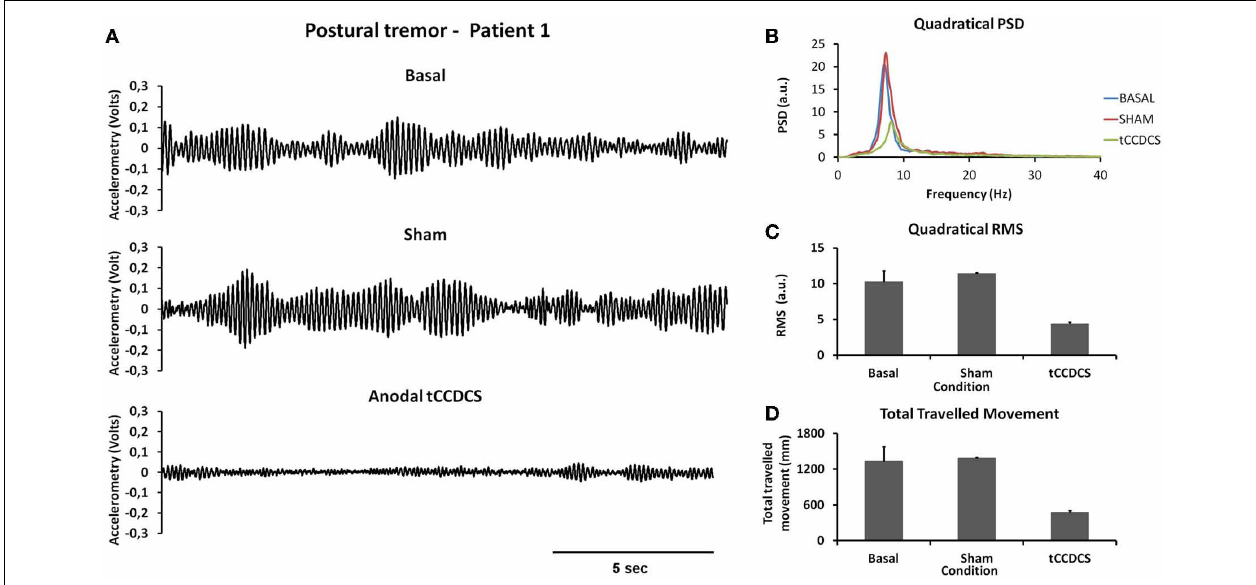
FIGURE 2 | Postural tremor in patient 1. (A) Tremor recorded at the level of right index in the 3 experimental conditions (from top to bottom: baseline, post-sham and post-tCCDCS) for the gravity axis (dominant axis in this task). Calibration value: 1.55mV = 100mm/s 2 . (B) Mean quadratical power spectral density (PSD) of all epochs of postural tremor, showing a marked reduction of